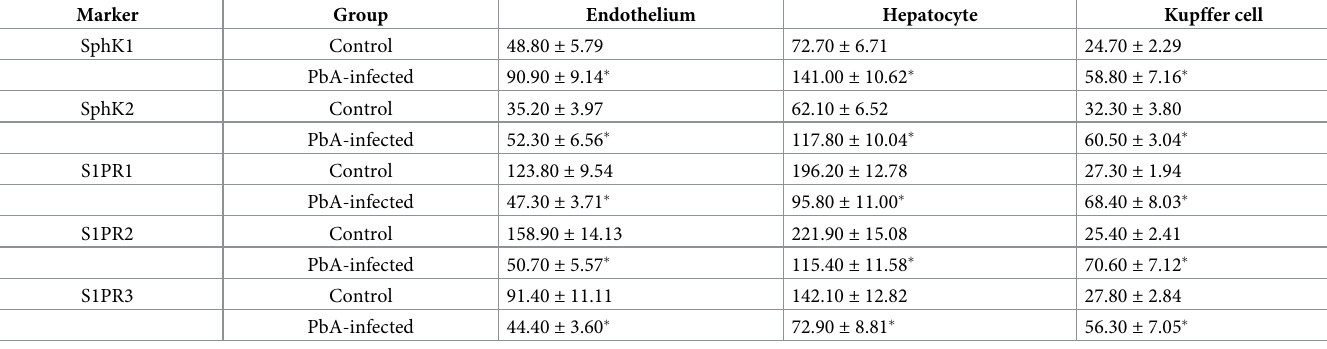
Table 4. Mean TS for S1PR and SphK expression in liver tissues from the control (n = 10) and PbA-infected (n = 10) groups.